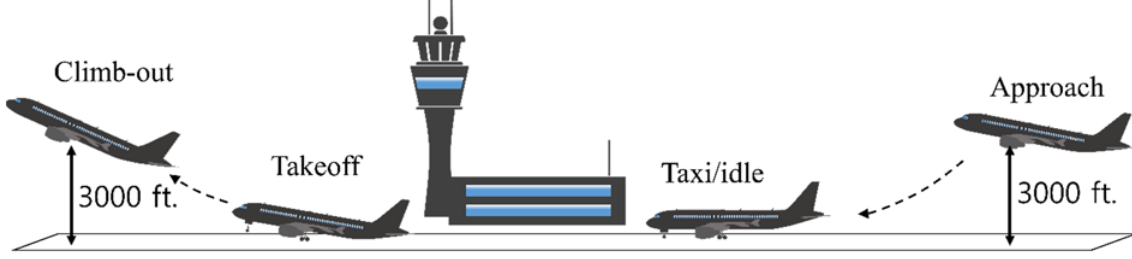
Figure 3. Standard LTO cycle. Table 2. Reference LTO cycle of subsonic aircraft [30].